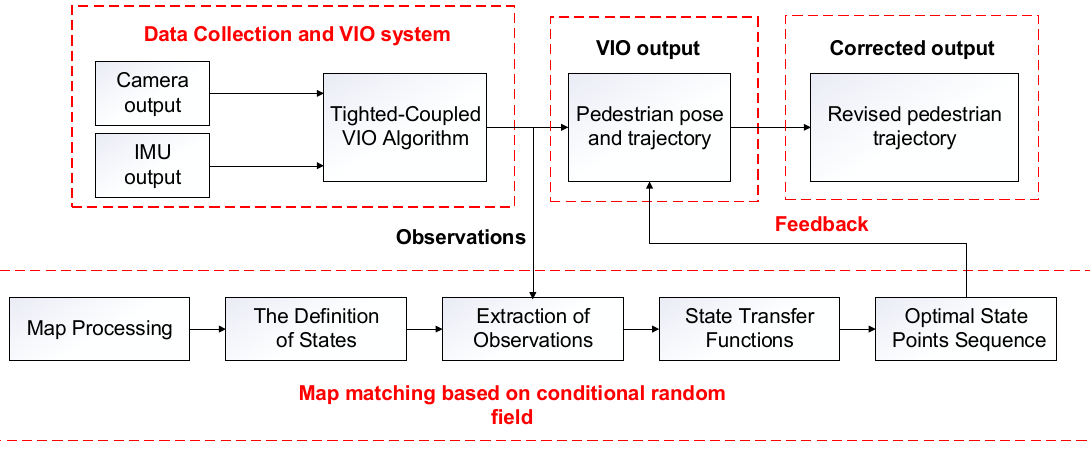
Figure 1. The framework of the proposed algorithm.